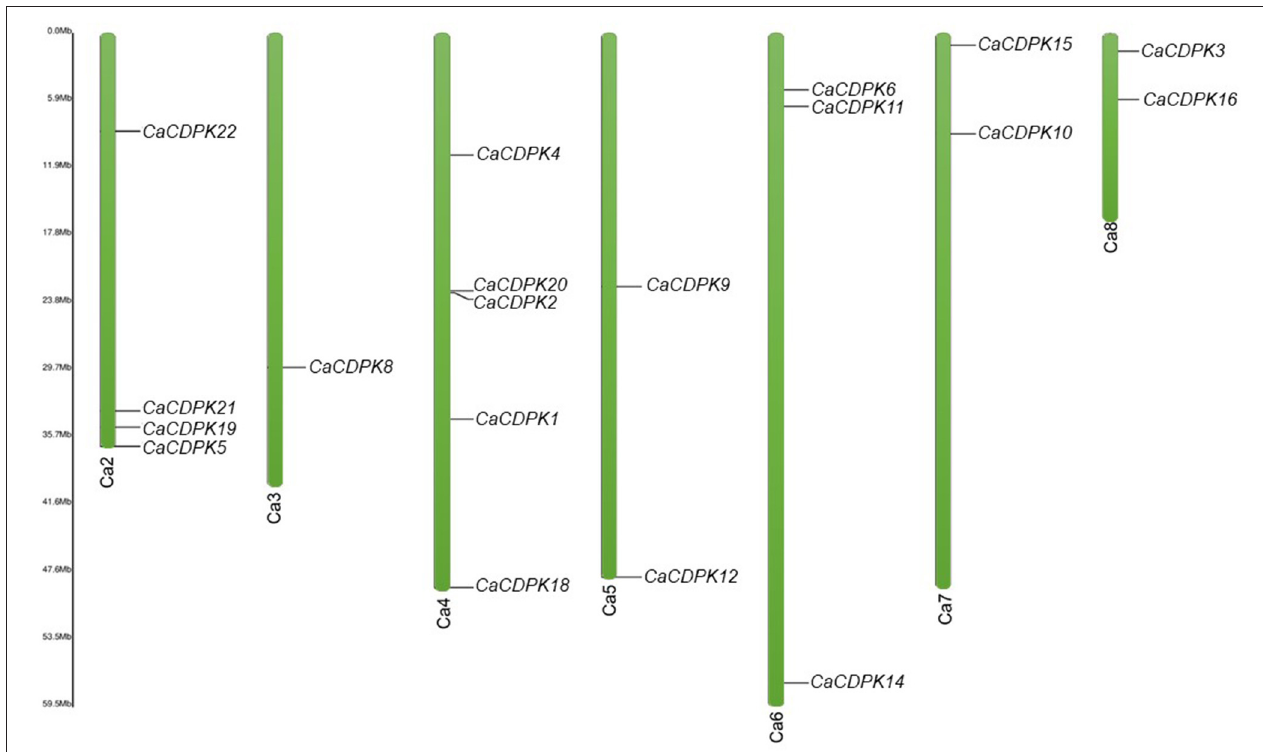
FIGURE 3 | Chromosomal locations of chickpea CDPK genes. Green color bars represent the chromosomes, the location of genes has been marked alongside. Chromosome numbers are given at the bottom of each chromosome. Except chromosome 1, the CDPK genes are distributed variably on seven